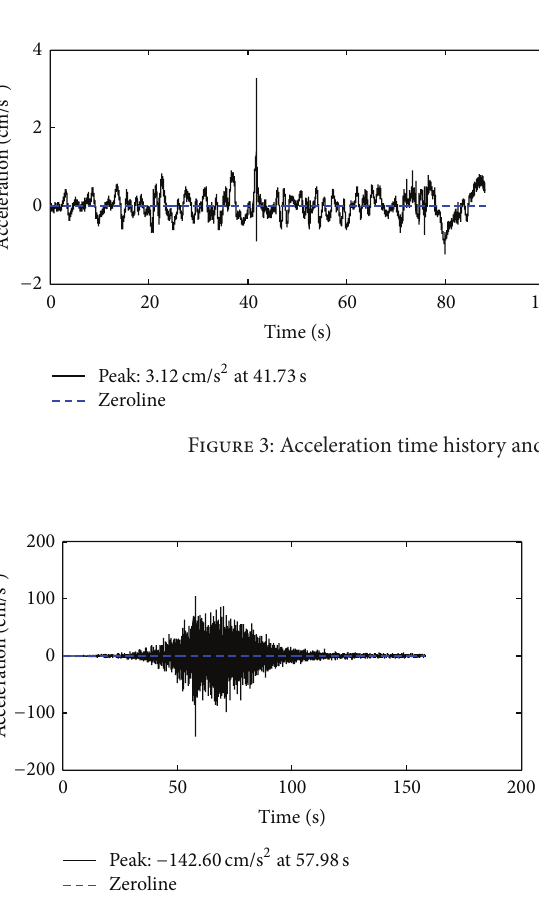
Figure 4: Acceleration time history and Jerk time history (062WIX080512142801).